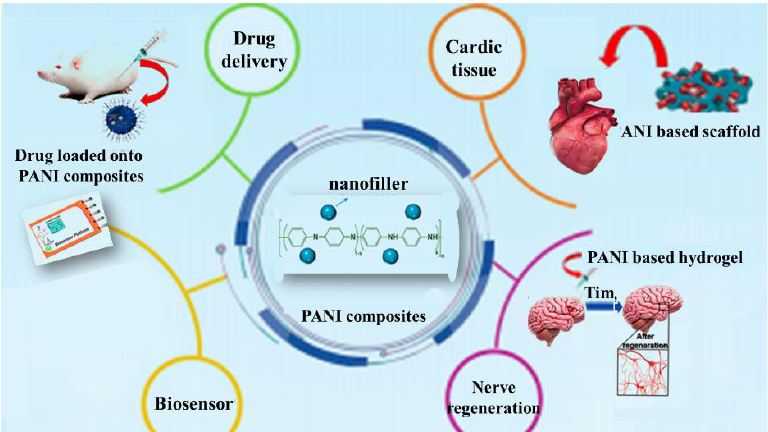
Figure 29. Schematic of PANI in medical applications. Reprinted with permission from Zare, E.N.; Makvandi, P.; Ashtari, B.; Rossi, F.; Motahari, A.; Perale, G. Progress in Conductive Polyaniline-